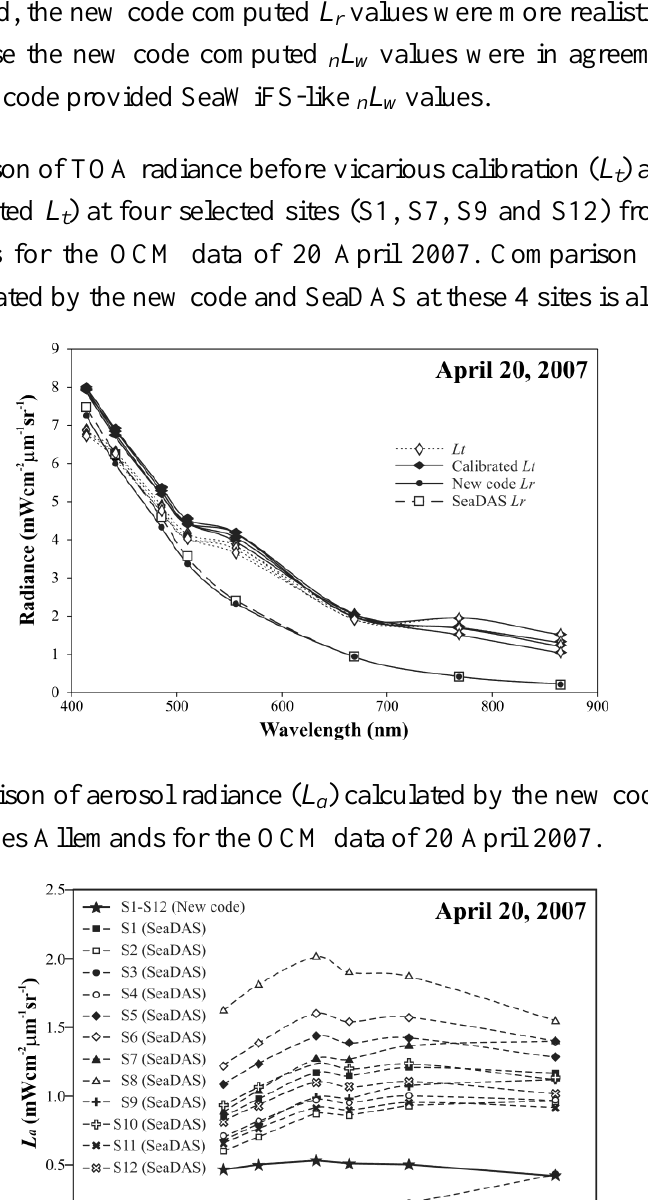
) and after vicarious t